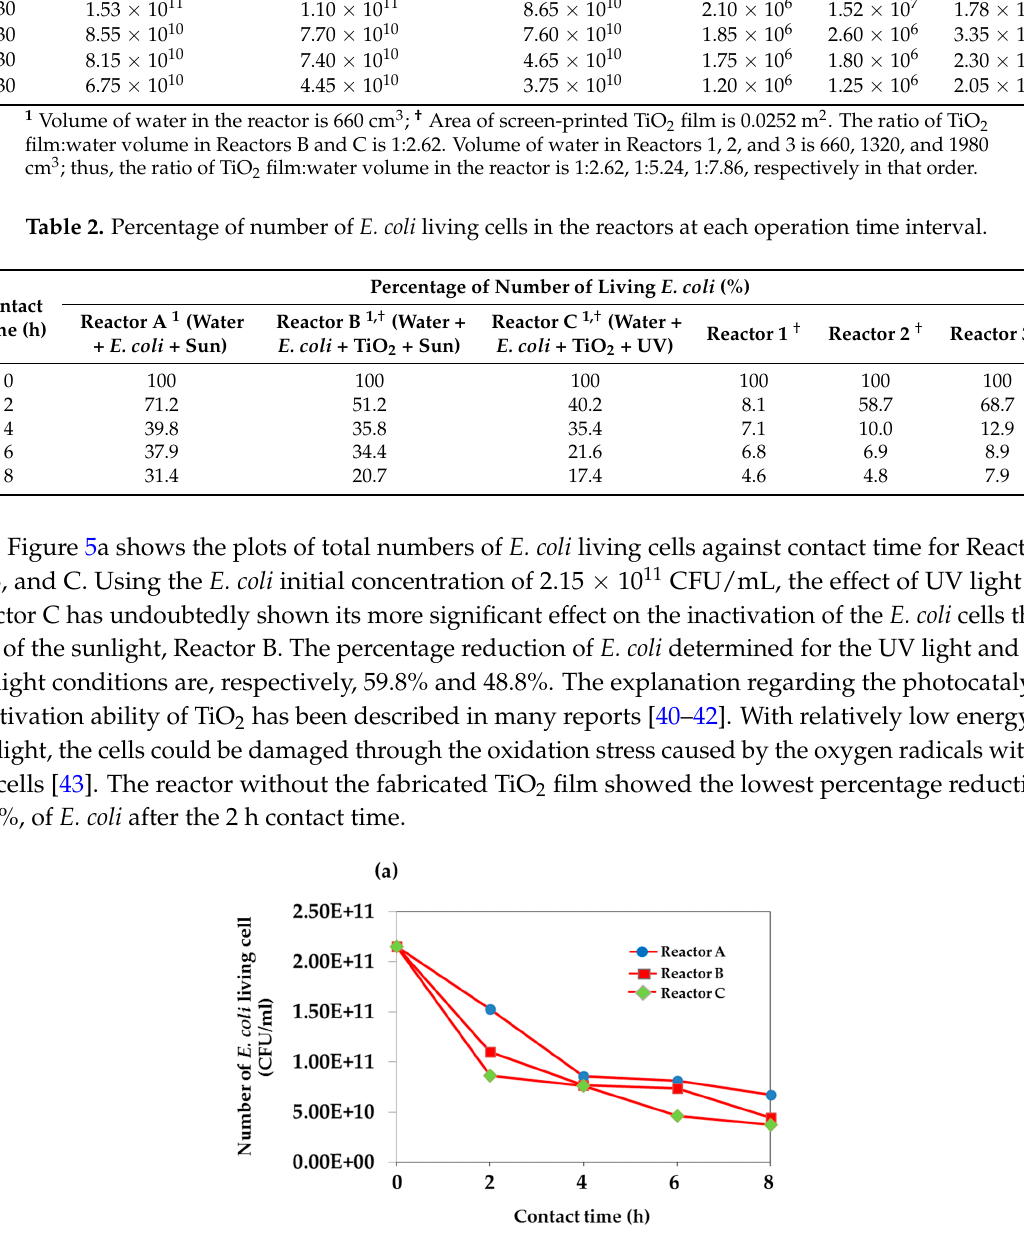
Table 1. Total numbers of E. coli living cells in the reactors at each operation time interval. Total Number of Living E. coil (CFU/mL) Time Materials 2016 , 9 , 808